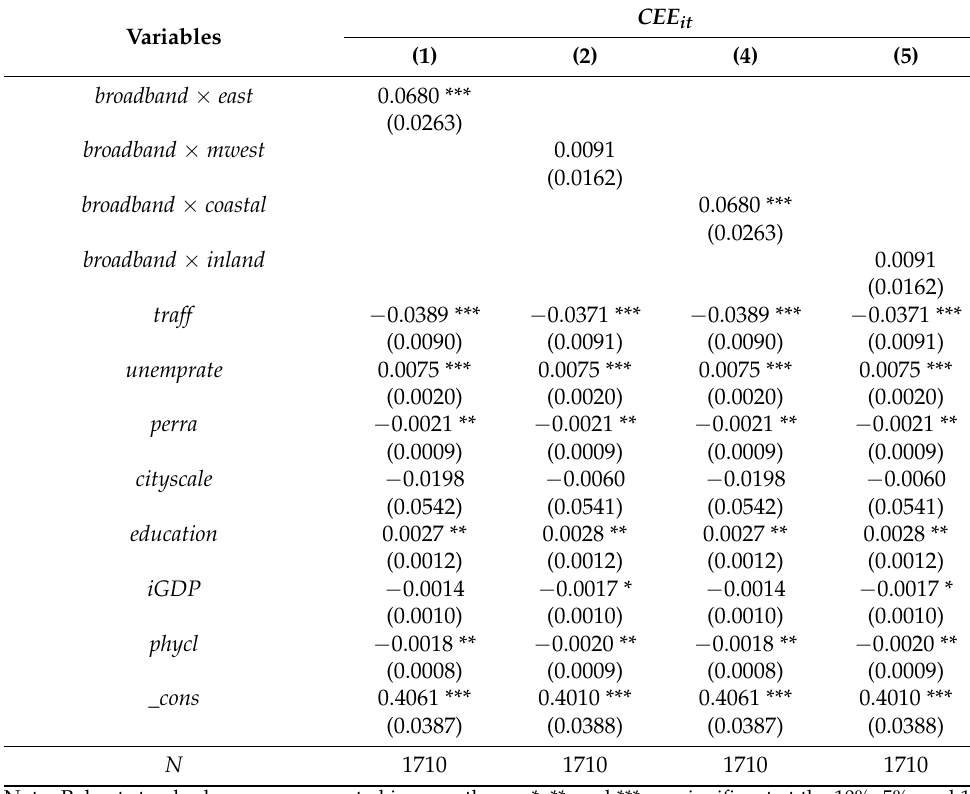
Table 6. Heterogeneity regression results for different city